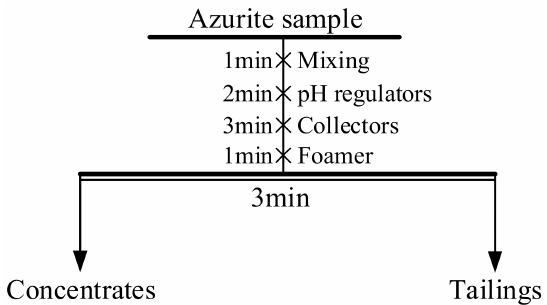
Figure 2. Flowsheets of flotation experiments of pure azurite